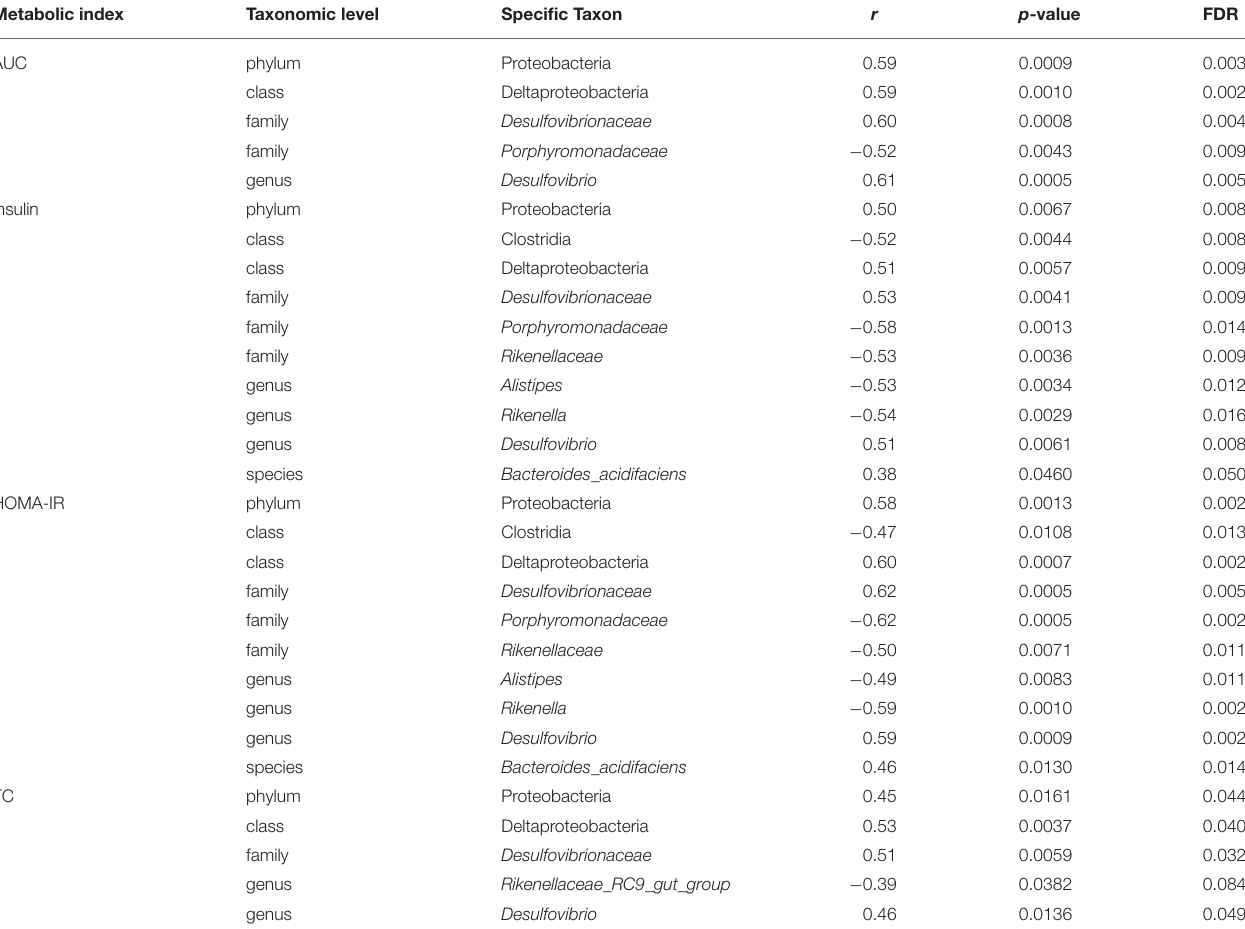
TABLE 2 | Correlation analyses between relative abundance of bacterial taxa at different taxonomic levels and glucose and lipid metabolism parameters ( n = 6–8/group). Metabolic